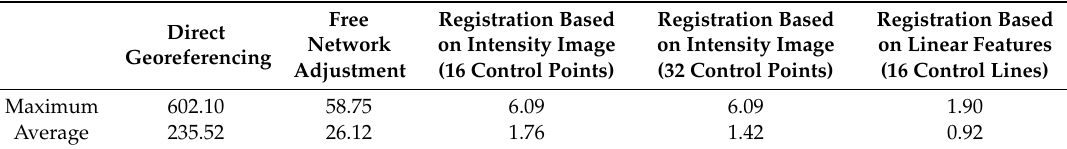
Table 2. Discrepancies between the two datasets before/after registration in different scenarios (unit: